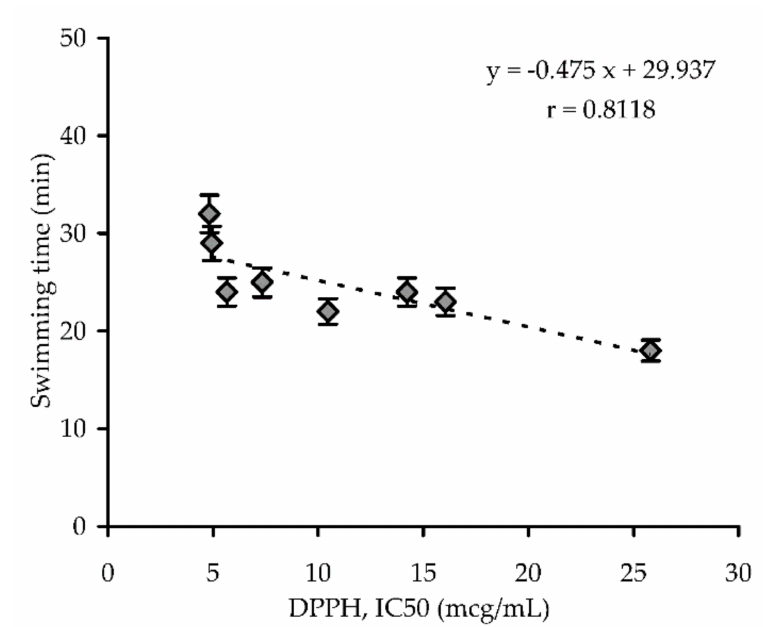
Figure 3. Correlation graph between radical scavenging ability of Rhododendron adamsii extracts against 2,2-diphenyl-1-picrylhydrazyl radicals (DPPH; independent variable x in regression equation) and swimming time of mice in swimming to exhaustion test on day 10 (dependent variable y in regression equation). r—correlation